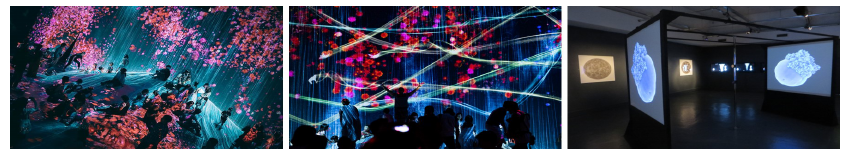
Figure 1. Example of smart interactive